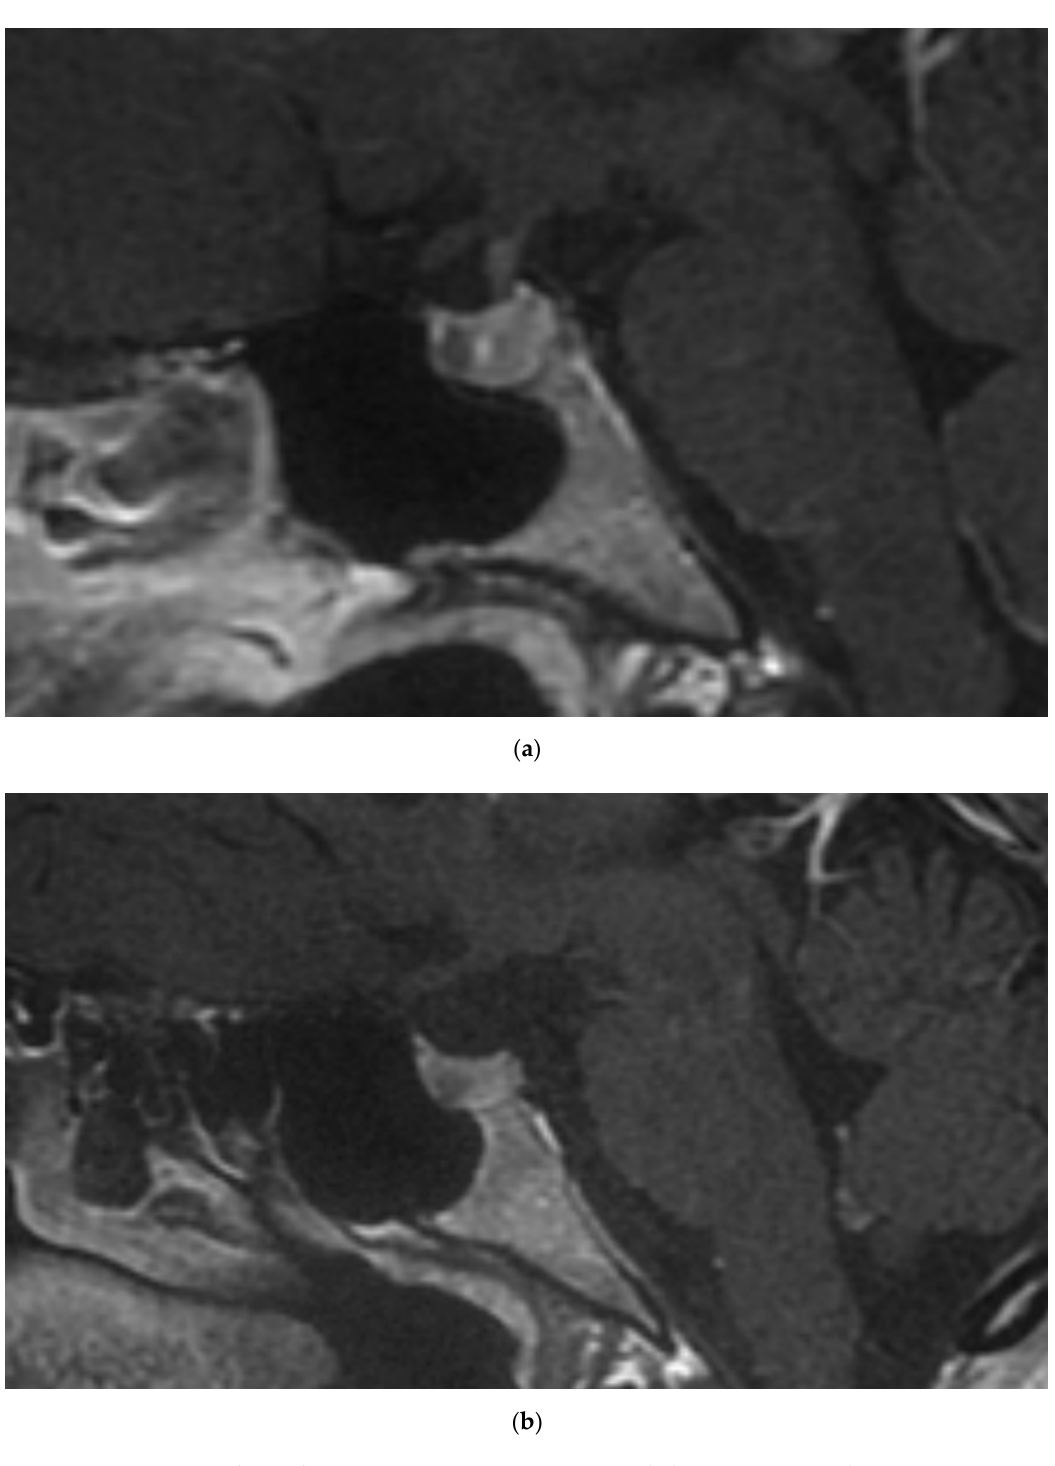
Figure 1. Contrast-enhanced magnetic resonance imaging revealed pituitary microadenomas in patient 2 ( a ) and patient 3 ( b ).